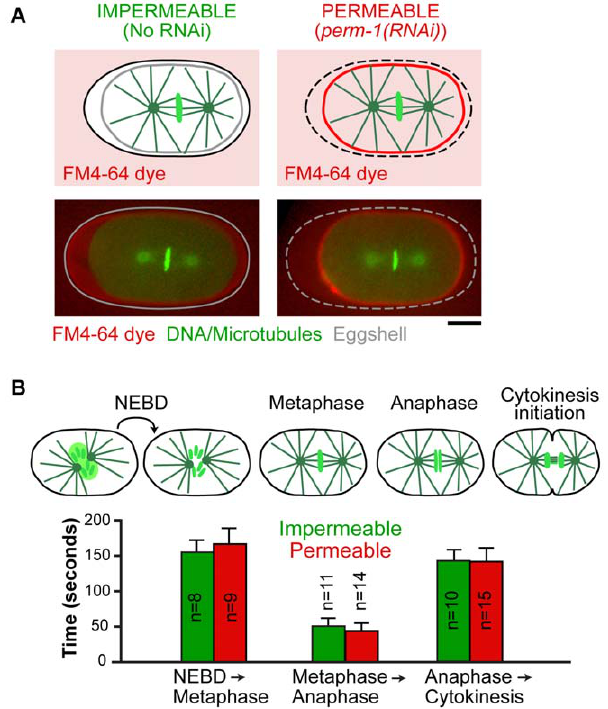
Figure 2. perm-1 inhibition permeabilizes the eggshell without altering cell division timing. A. Schematics and confocal images of impermeable (no RNAi) and permeable ( perm-1(RNAi) ) embryos co- expressing GFP-histone H2B and GFP-alpha-tubulin. Embryos at meta- phase of the first mitotic division were submerged in media containing the lipophilic dye FM4-64, which passes through the eggshell to label the plasma membrane of permeable ( right ), but not impermeable ( left ) embryos. Scale bar, 10 m m. B. Time intervals between NEBD and metaphase, metaphase and anaphase, and anaphase and cytokinesis onset were measured for permeable embryos ( perm-1(RNAi) ); redbars ) and impermeable wild-type controls ( greenbars ).